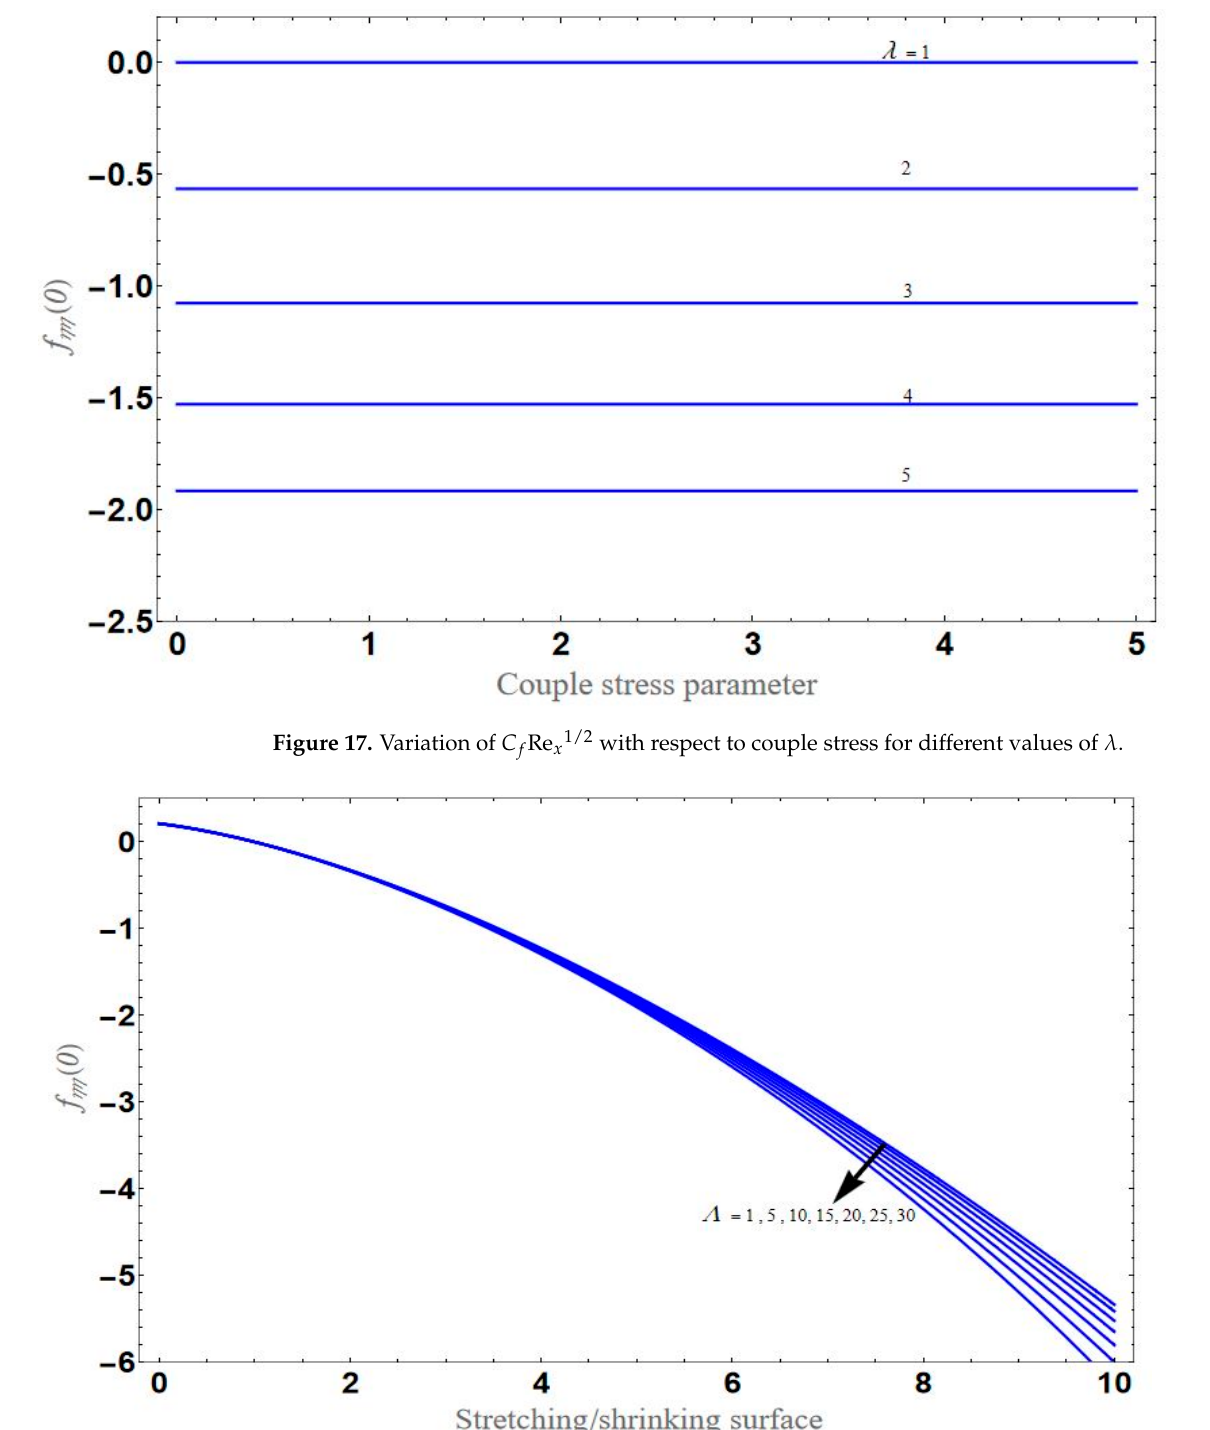
Figure 16. Pattern of streamline flows for ( a ) suction and ( b ) injection cases.